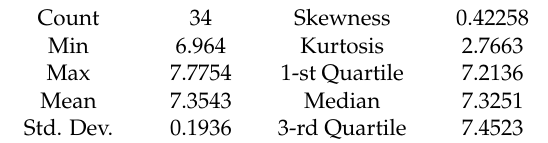
Figure 4. The distribution of the sampled meteorological stations in the Jema watershed. Table 2. The descriptive statistics for the mean annual total rainfall (MATRF) of the sample stations.